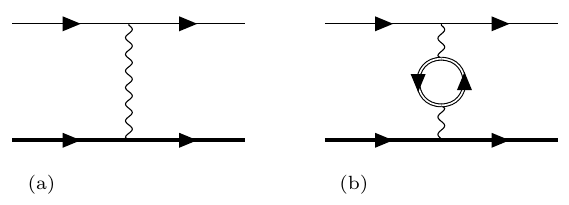
Figure 1. LO diagram, (a), and NLO diagram, (b), with leptonic corrections. The thick fermionic line represents the muon current, while the double line closed loop stands for the virtual leptonic contribution due to a generic lepton ‘ .